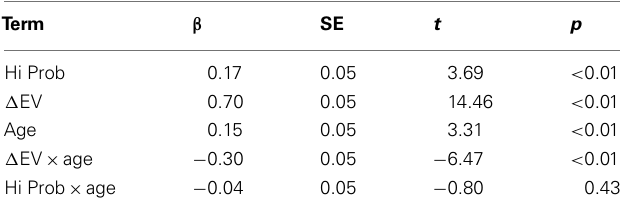
Table 3 | Multiple regression of the standardized, logit-transformed proportion of high probability choices on 96 independent trials in the instructed gambling block by k younger or older adults, with one RA-related predictor (Hi Prob), one EV-related predictor ( Δ EV), and a dummy-coded age